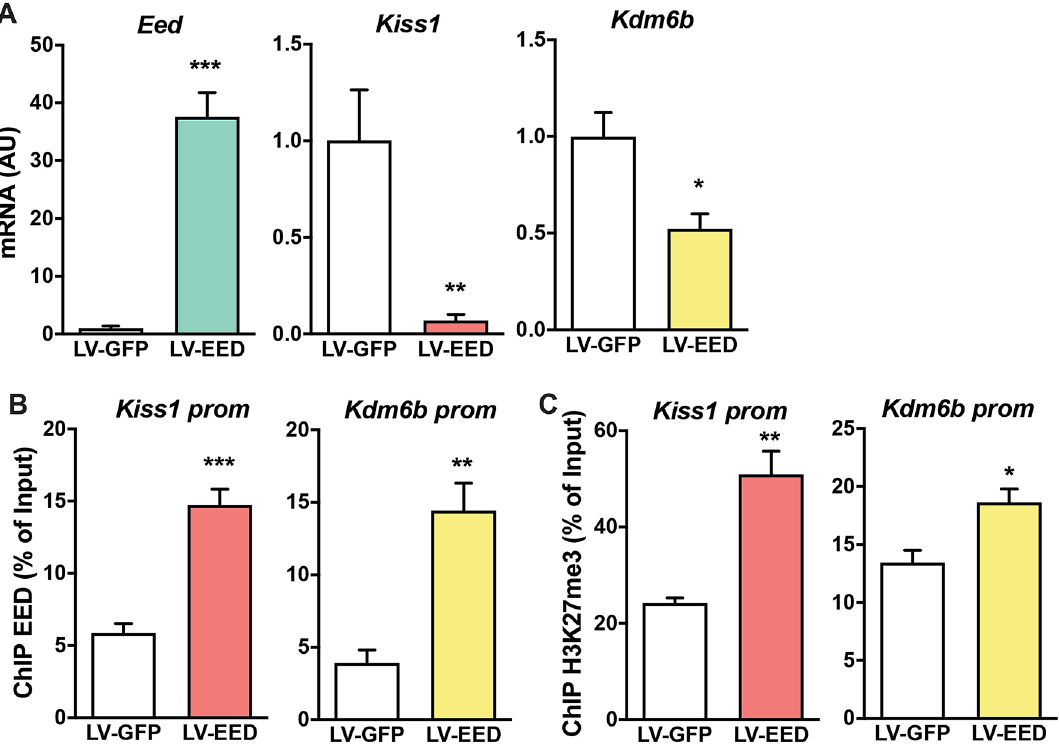
Figure 5. Changes in Gene Expression and recruitment of EED and H3K27me3 to the promoter of network genes. ( A ) Gene expression in R22 cells stably expressing EED. mRNA levels were measured by qPCR. Results are expressed as fold change with respect to control LV-GFP group. *p < 0.05, ***p < 0.001 vs. LV-GFP- Control (n = 4 per group). ( B ) Recruitment of EED to the promoters of Kiss1 and Kdm6b in R22 cells overexpressing EED. ( C ) Increased H3K27me3 abundance at the promoter of Kiss1 and Kdm6b in R22 cells after EED overexpression. Results are expressed as fold-change with respect to cells transduced with LV-GFP. *p < 0.05,